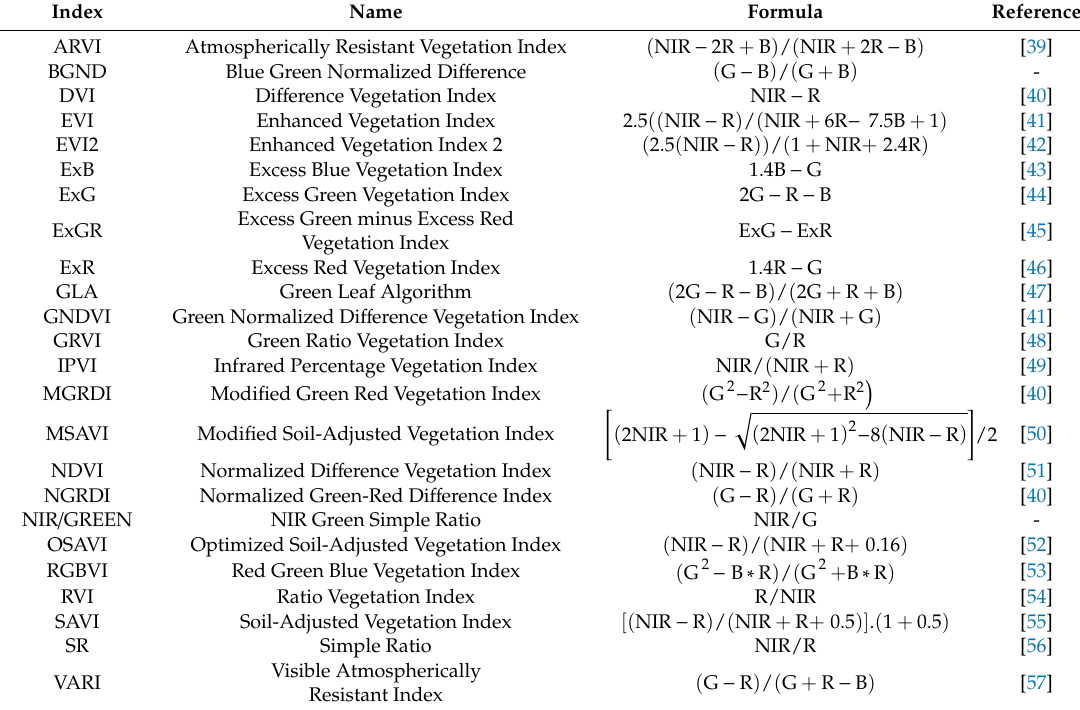
Table 2. Summary of the vegetation indices (VIs) used in this study for pasture aboveground biomass (AGB) and canopy height (CH)